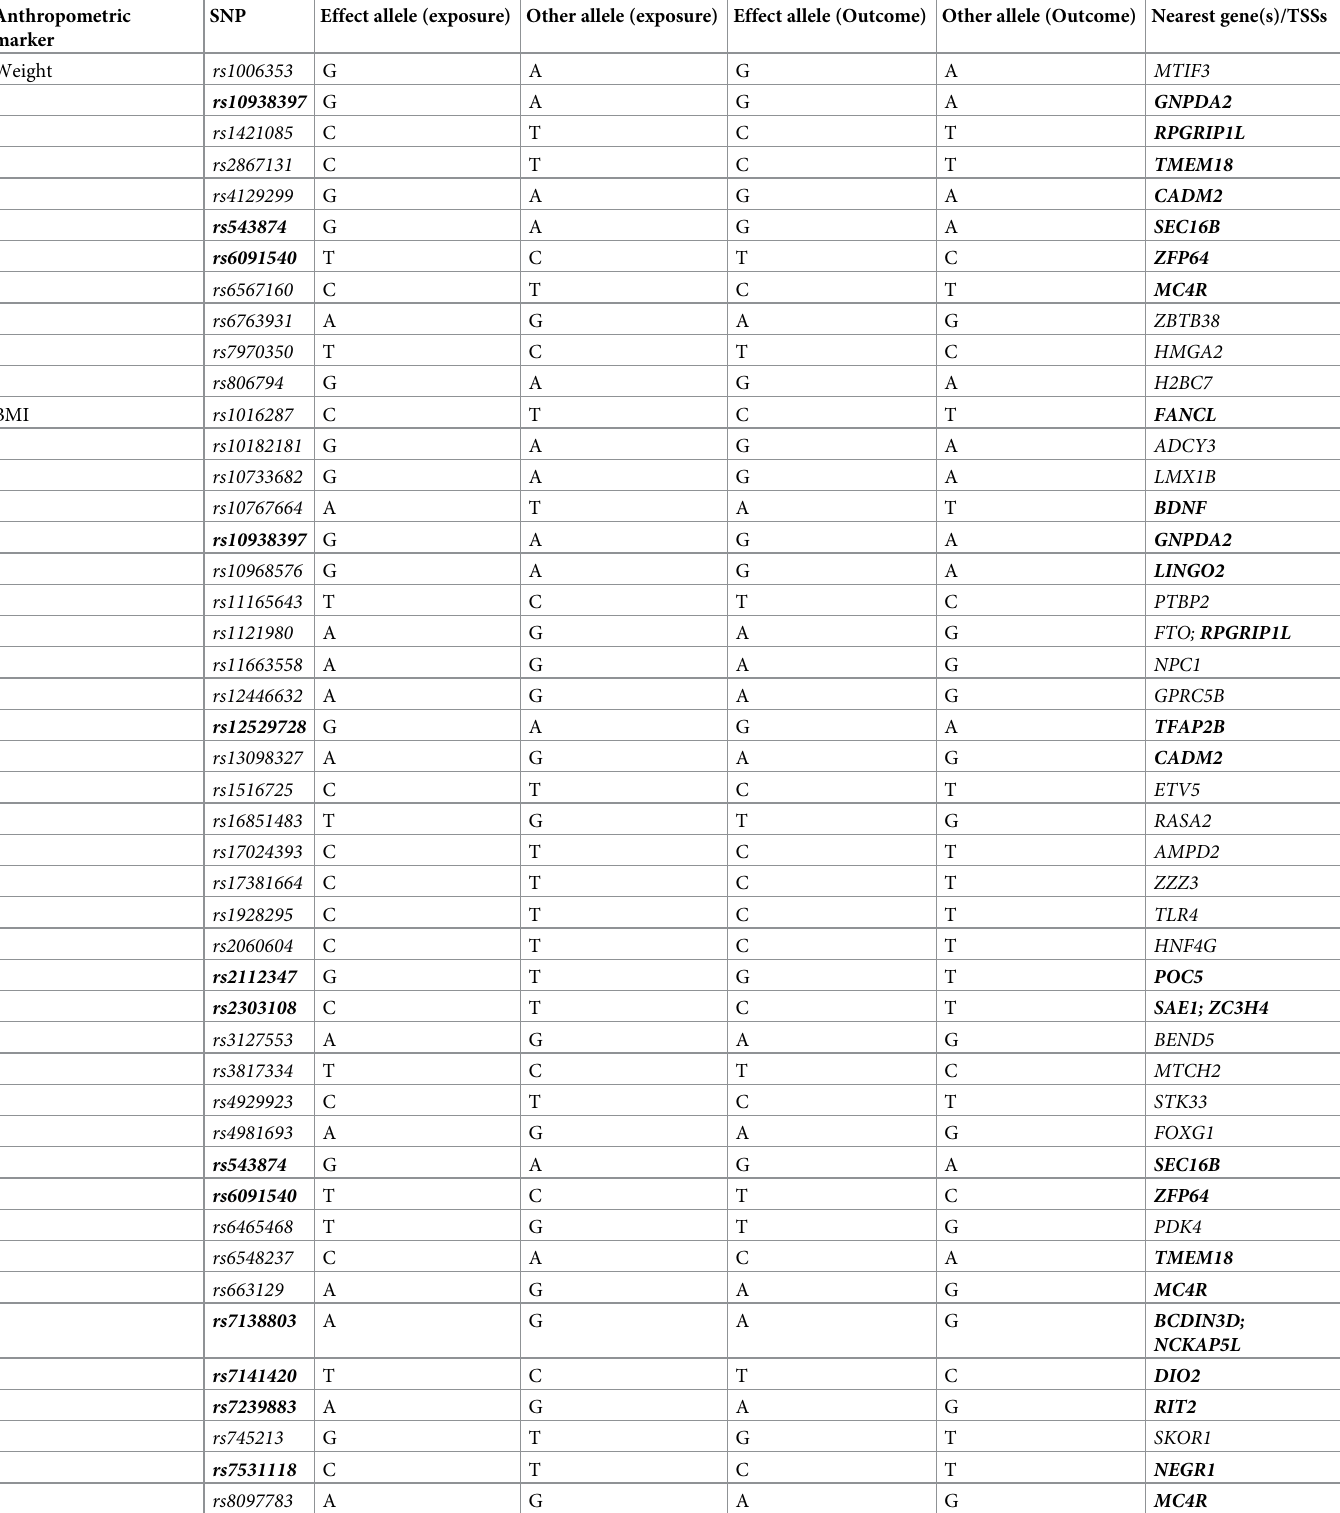
Table 5. Genetic variants (SNPs) and nearest genes/transcriptional start sites (TSSs) underlying the significant causal associations. Anthropometric